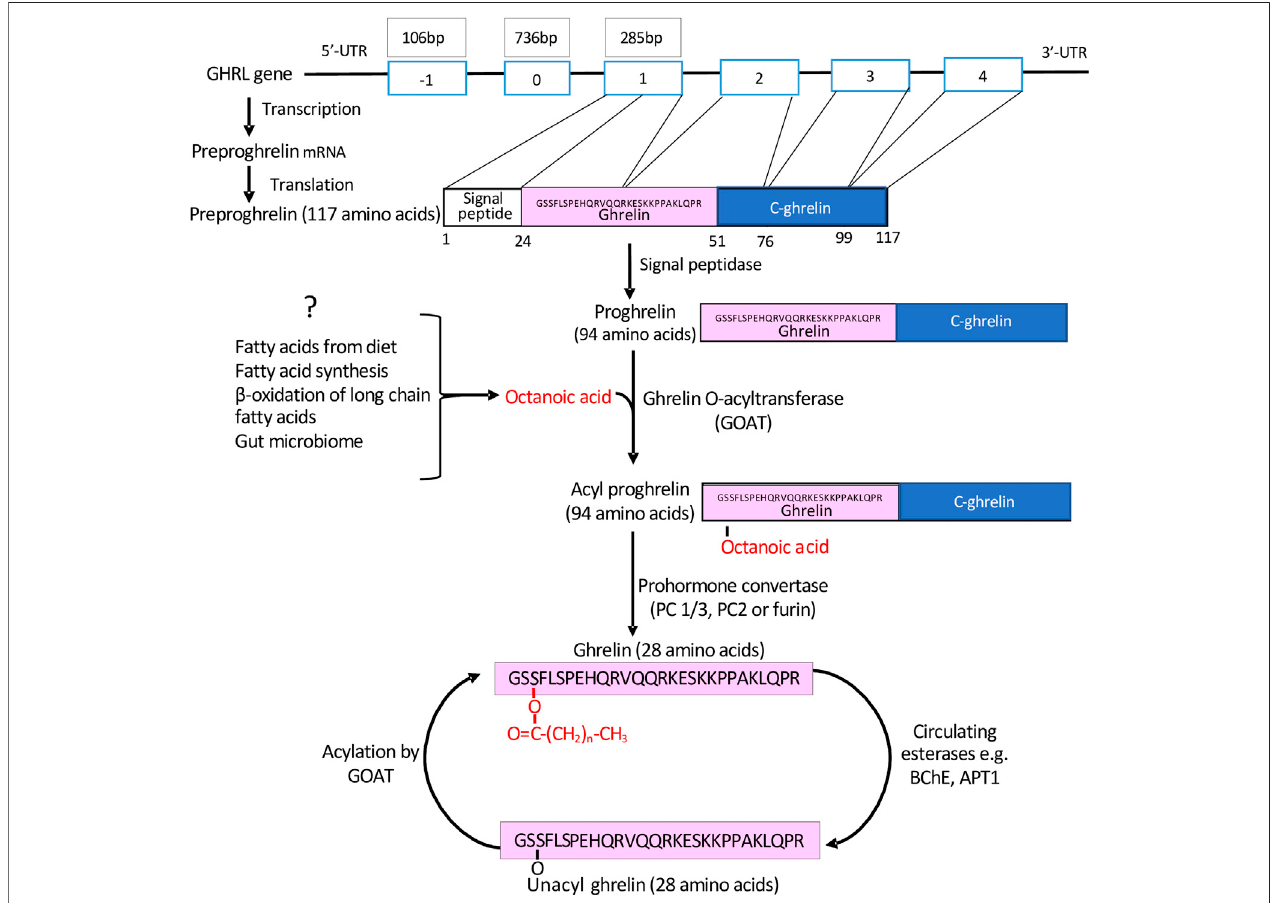
FIGURE 1 | The generation of mature acyl-ghrelin. Following transcription and translation of the GHRL gene, a preproghrelin peptide of 117 amino acids is generated. This undergoes proteolytic cleavage to generate proghrelin (94 amino acids). Either proghrelin or mature ghrelin (28 amino acids) can undergo acylation by GOAT, which is predominately bound by C8. Acyl-ghrelin may be deacylated by esterases and then reacylated by GOAT at an alternative location.